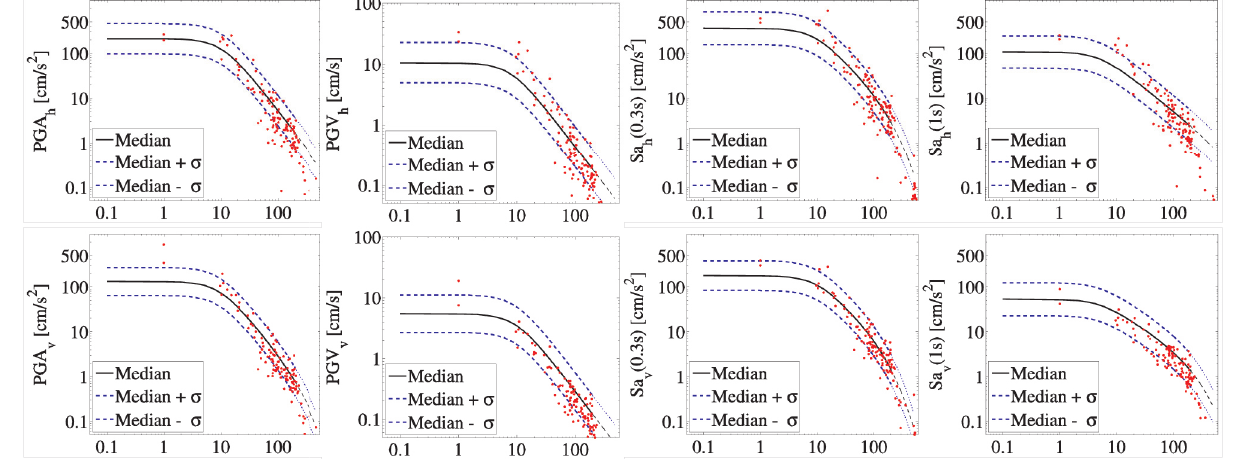
(0.3s), S (1.0s), for the geometric mean of the horizontal (h sub- a a jb